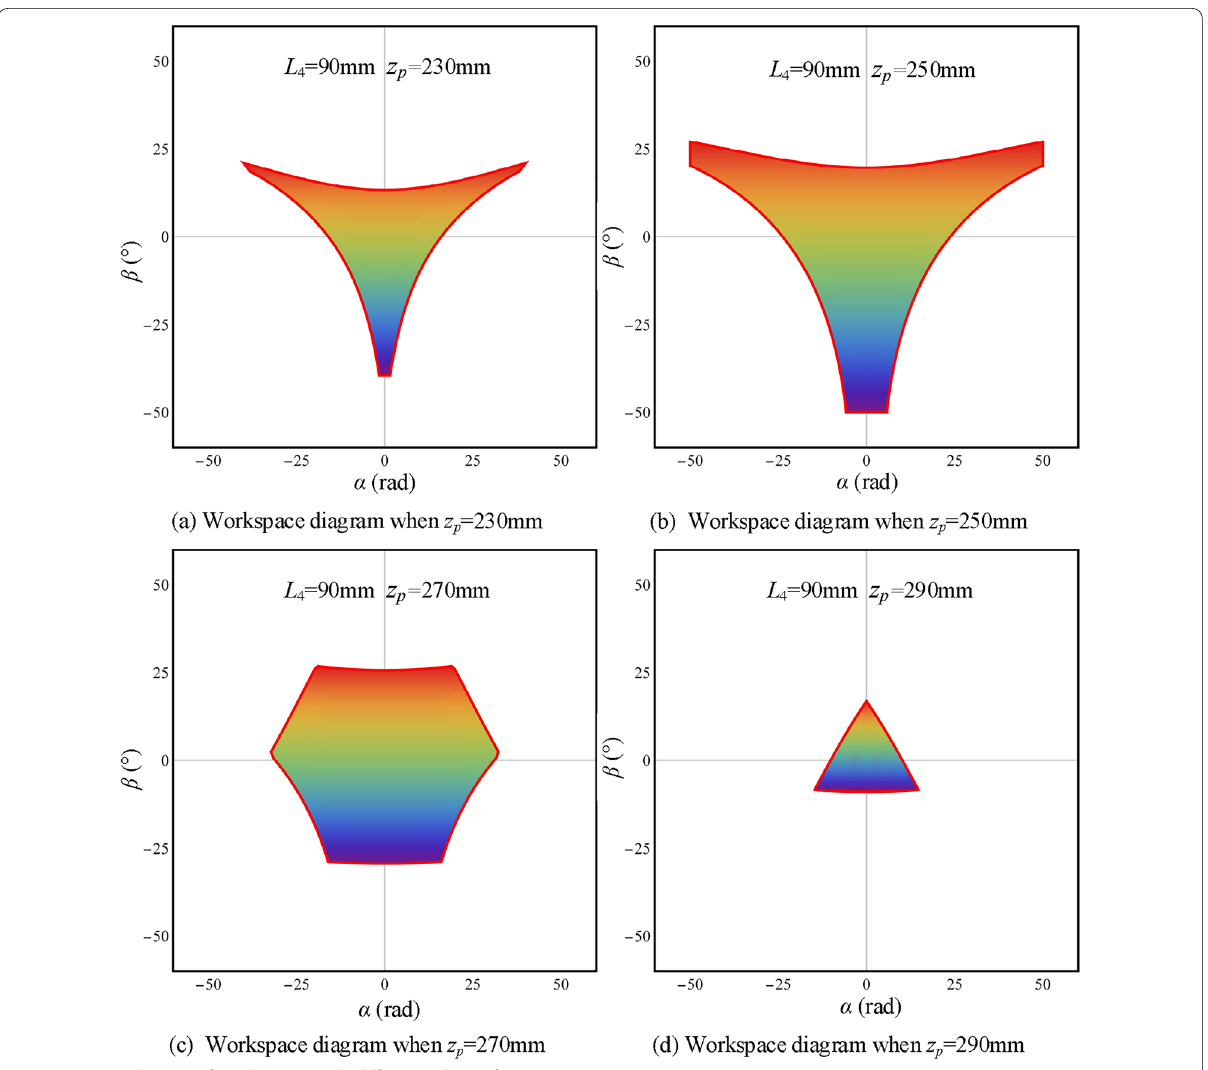
Figure 10 Workspace of mechanism with different values of z p